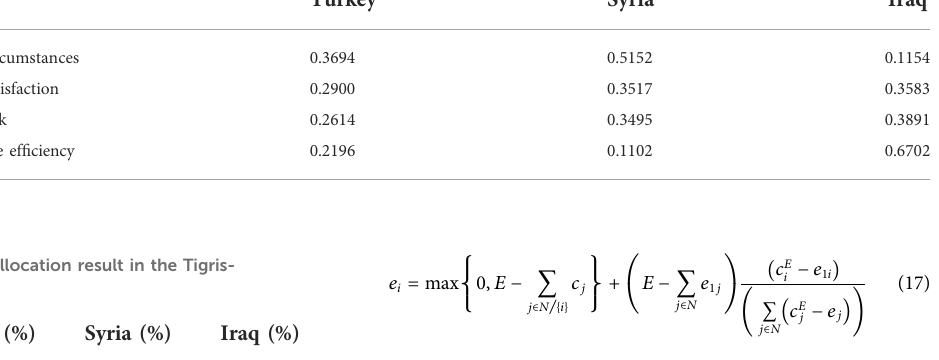
TABLE 8 The adjusted coef fi cient of three countries. Country